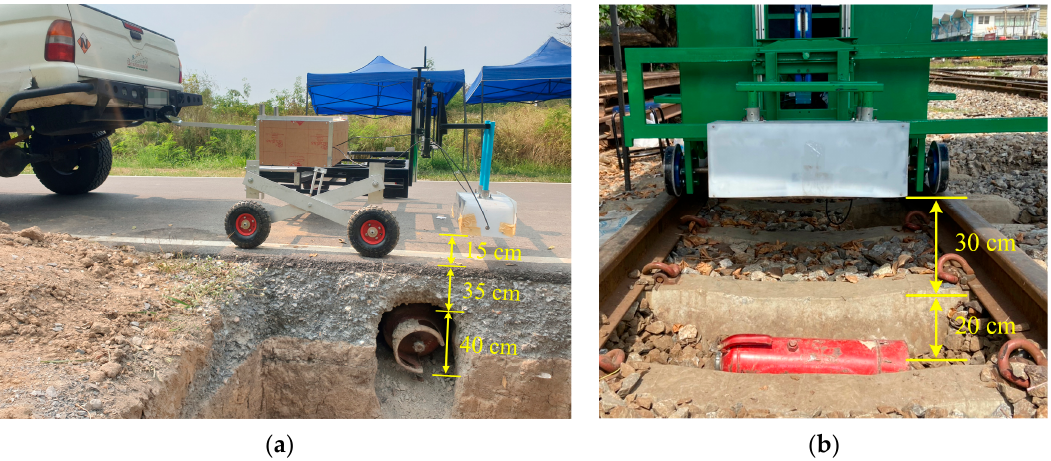
Figure 11. Experimental setup of the implemented GPR for detection of an IED buried under: ( a ) a road; ( b ) a